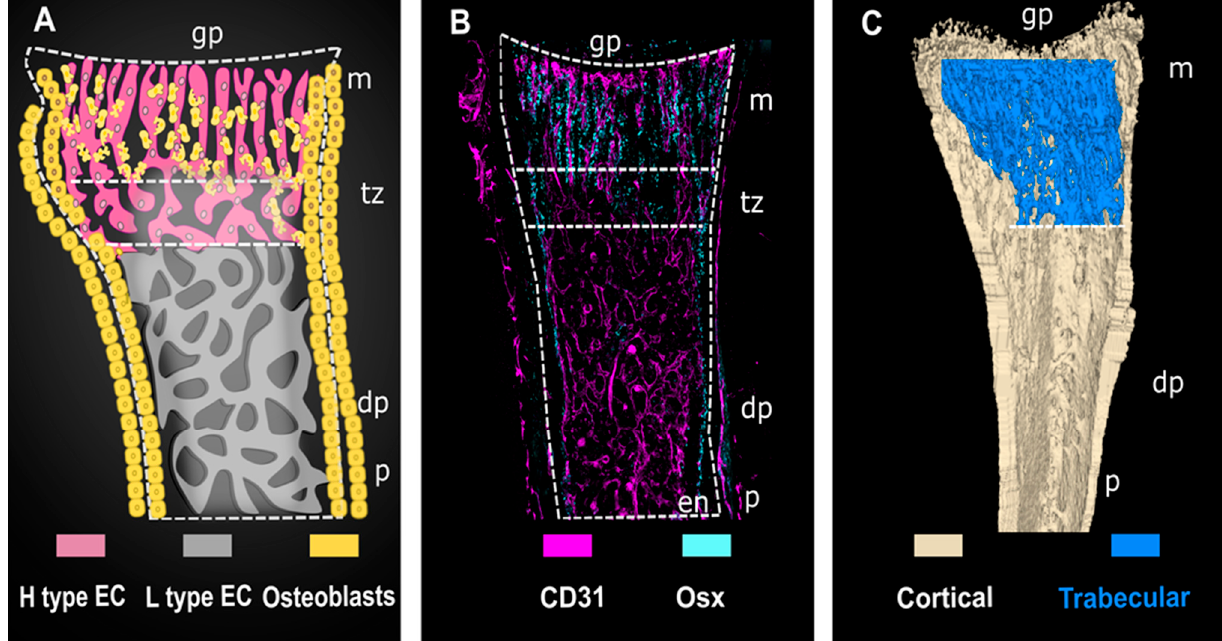
Figure 1. Compartmentalization of the murine long bone and its capillary network. H-type vessels are presented with their main interacting partners, Osx + cells, in the postnatal murine long bone. Left to right: ( A ) Schematic diagram illustrates H- (magenta) and L-type (grey) vessels with their distinct morphology and emphasizes the strict geographical distribution of Osx + osteoprogenitors in the metaphysis as compared to the diaphysis. Osteoprogenitors in the metaphysis (indicated by yellow, irregular-shaped cells) are presented closely associated to H-type capillaries during their migration to sites of trabecular bone formation. Located in the endosteum and periosteum is a pool of osteoprogenitors (indicated by yellow, cuboid-shaped cells) not associated with H-type vessels. H-type vessels are columnar formations perpendicularly oriented against the lowermost point of the avascular growth plate in long bones. L-type vessels are localised to the diaphysis where they form a sinusoidal hypoxic vessel bed surrounded by bone marrow cells (not represented). H- and L-type vessels form a continuous vascular network; the area where these H-type capillaries begin to converge into L-type capillaries has been branded the transition zone, an area with a vascular web of an intermediate phenotype between these two capillaries. ( B ) High-resolution confocal imaging of CD31 and Osx, labelling endothelial cells (magenta) and osteoprogenitors (cyan), respectively. Postnatal day 4 (P4) tibia sectioned on the axial plane illustrates the specific localization of bone-forming cells around H vessels in the metaphysis, endosteum, and periosteum. Note the formation of arches and bulges at the caudal point of the growth plate, as previously described. ( C ) Illustration of the compartmentalization of the long bone. Pseudocolored, micro-computed tomography, 2D plane snapshot from a 3D bone mesh model. Trabecular bone (blue)